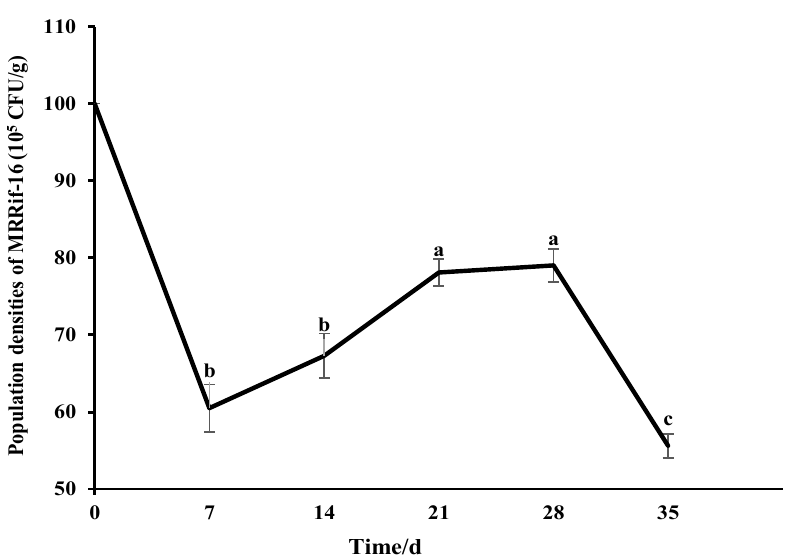
Figure 5. Colonization of MRRif‑16 in the soil in which S. divaricata was grown. Soil samples were treated with a spore suspension of MRRif‑16 at a final density of 10 7 CFU per gram of soil. After 7 d, 14 d, 21 d, 28 d, and 35 d of inoculation, the population densities of the MRRif‑16 were determined. The different letters indicate significant differences in Duncan’s DMRT ( p < 0.05).